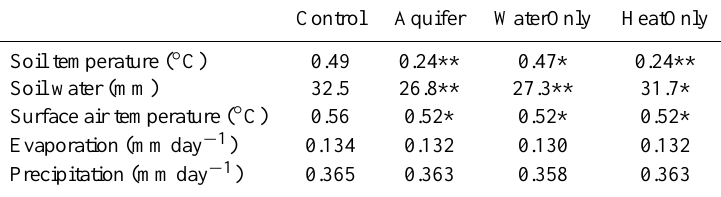
Table 2. Interannual standard deviation of climate variables.